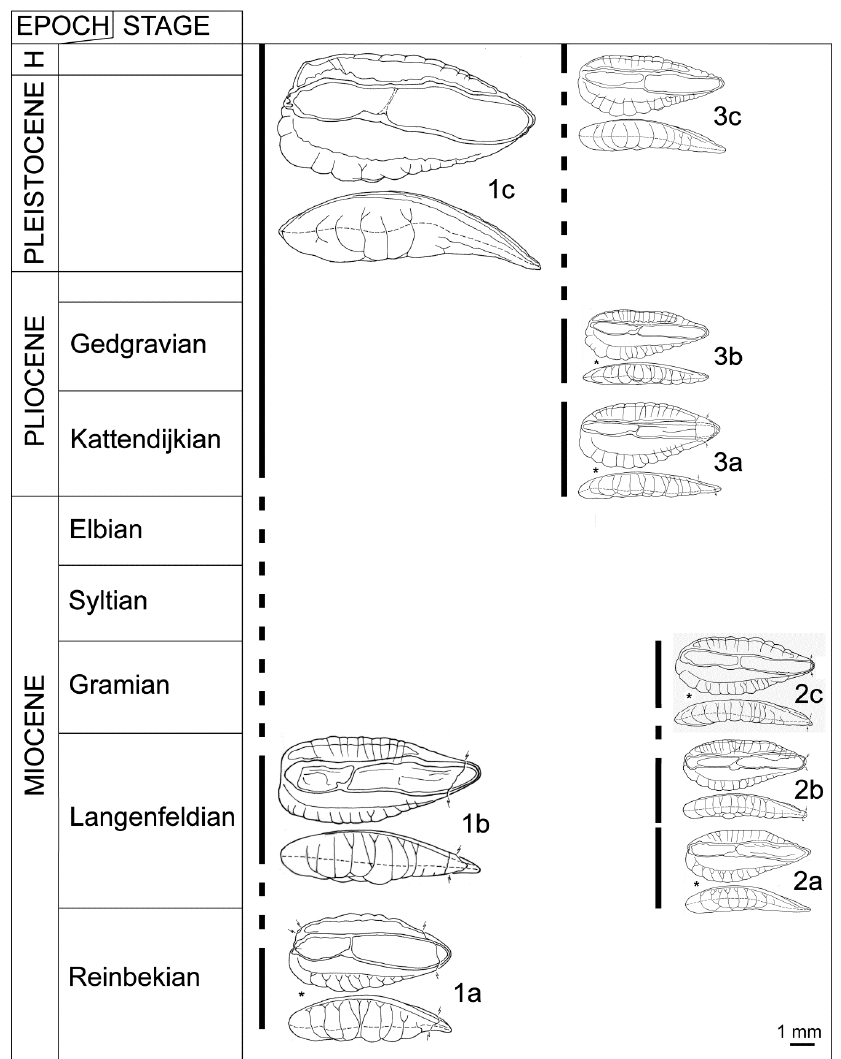
Figure 17. Evolutionary lineages of Allotrisopterus and Neocolliolus sensu lato. Otoliths indicated with an asterisk are mirror images. ( 17.1a ) Allotrisopterus minutus n. ssp.1, Reinbekian, borehole Straat,